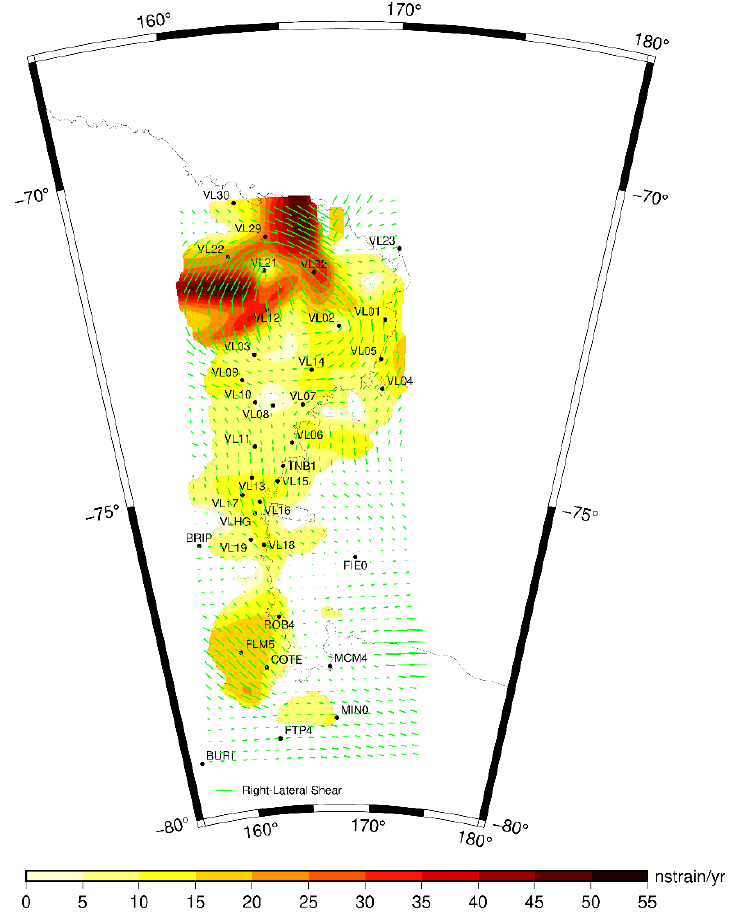
Figure 4. Maximum shear strain rates of Victoria Land. Green lines depict the directions of maximum right lateral shear values while yellow to black colors show the magnitude of statistically significant values at 1σ. Blanked grid cells correspond to area with statistically not significant values.